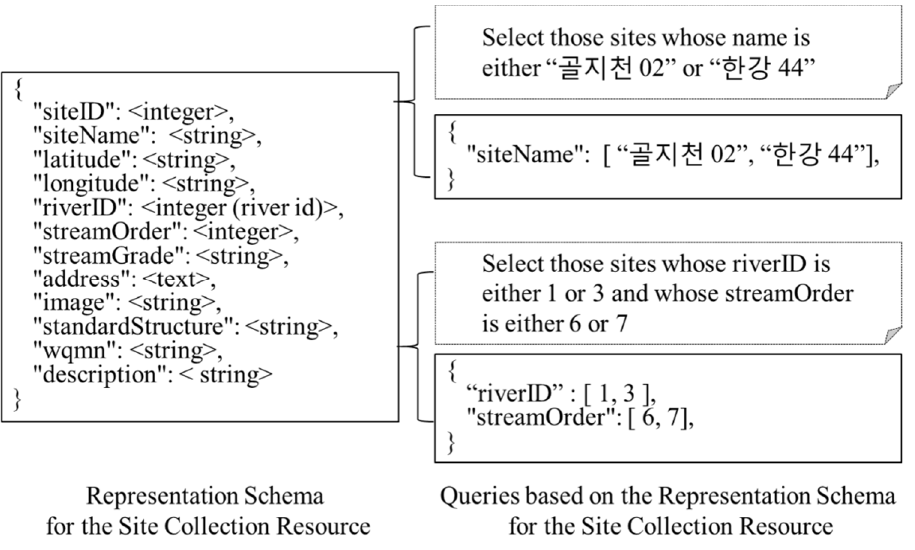
Figure 8. Logical model for the query in OSAEM.